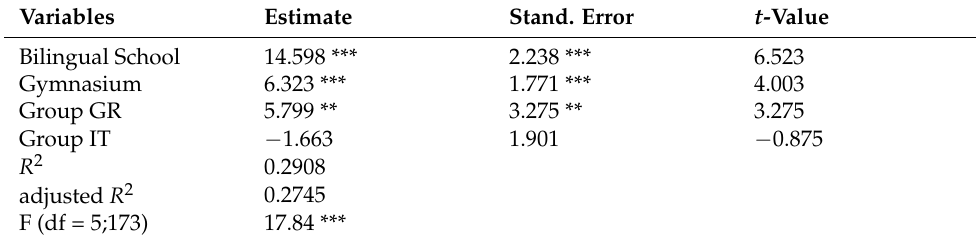
Table A2. Effects of school type and language group on LAT scores in L2.